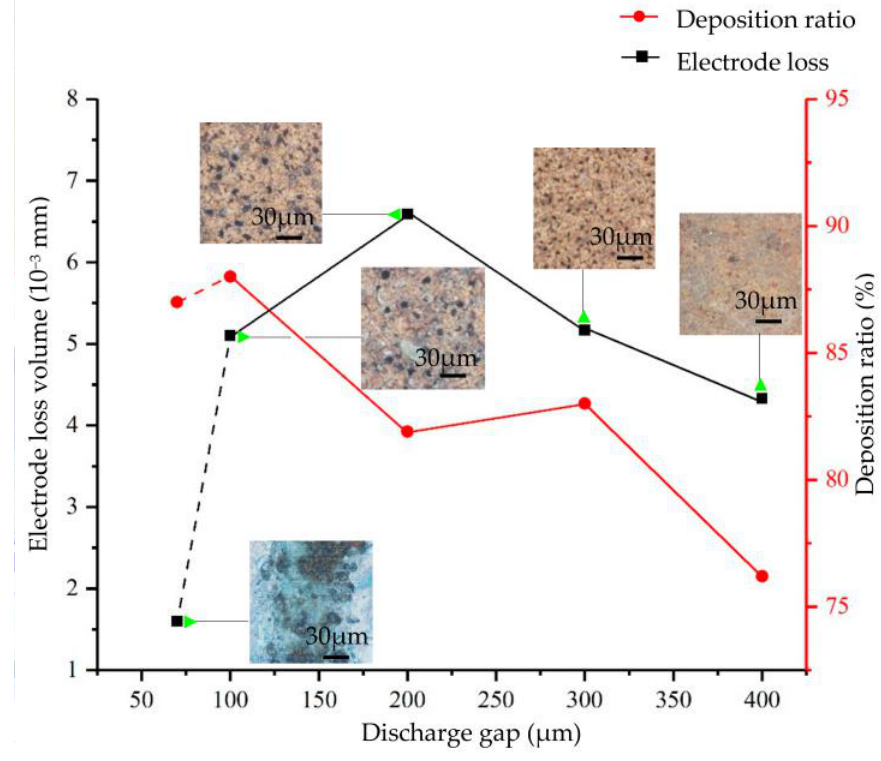
Figure 14. The e ff ect of discharge gap on electrode loss volume and deposition ratio.